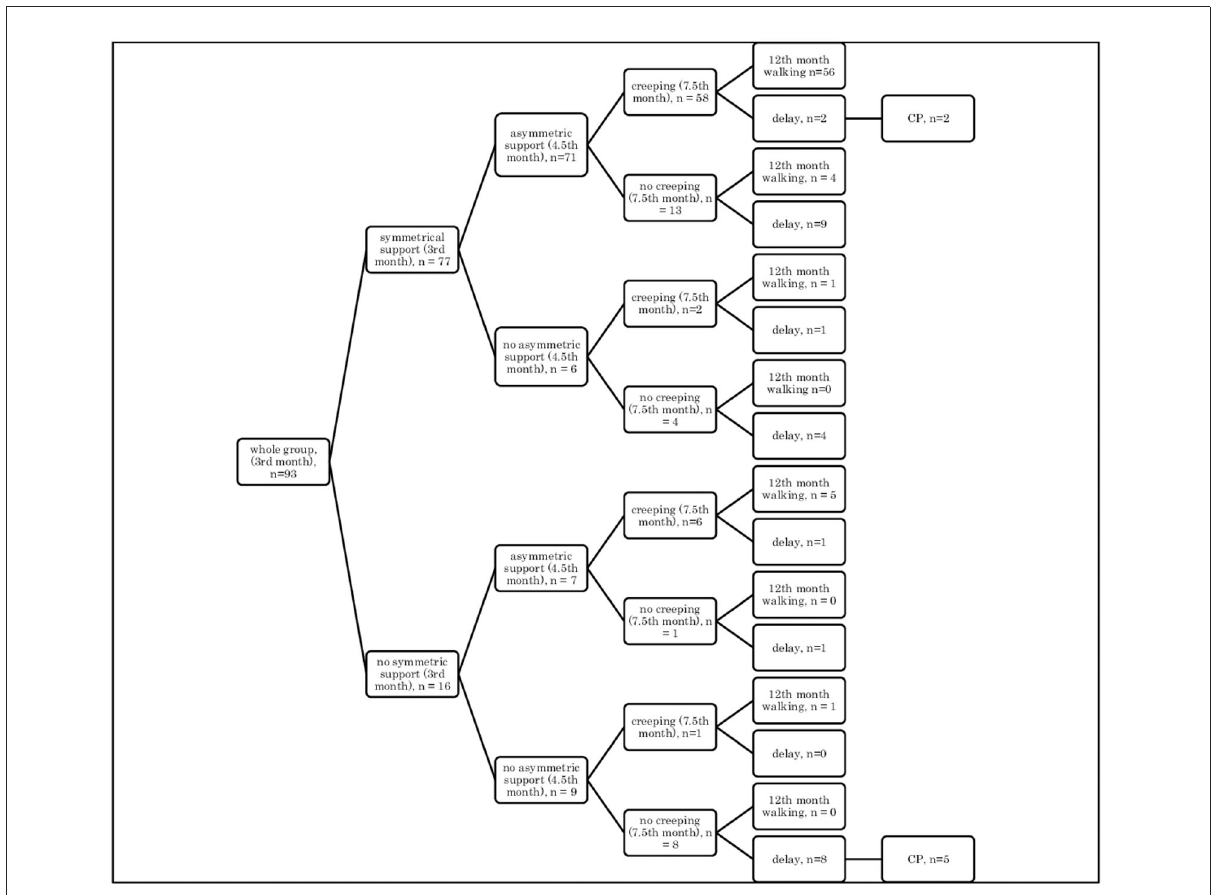
FIGURE3 Motor development in the supine position: a quadrangle of support (3rd month); turning to the side (4.5th month); crawl position (7.5th month), and independent walking (12th